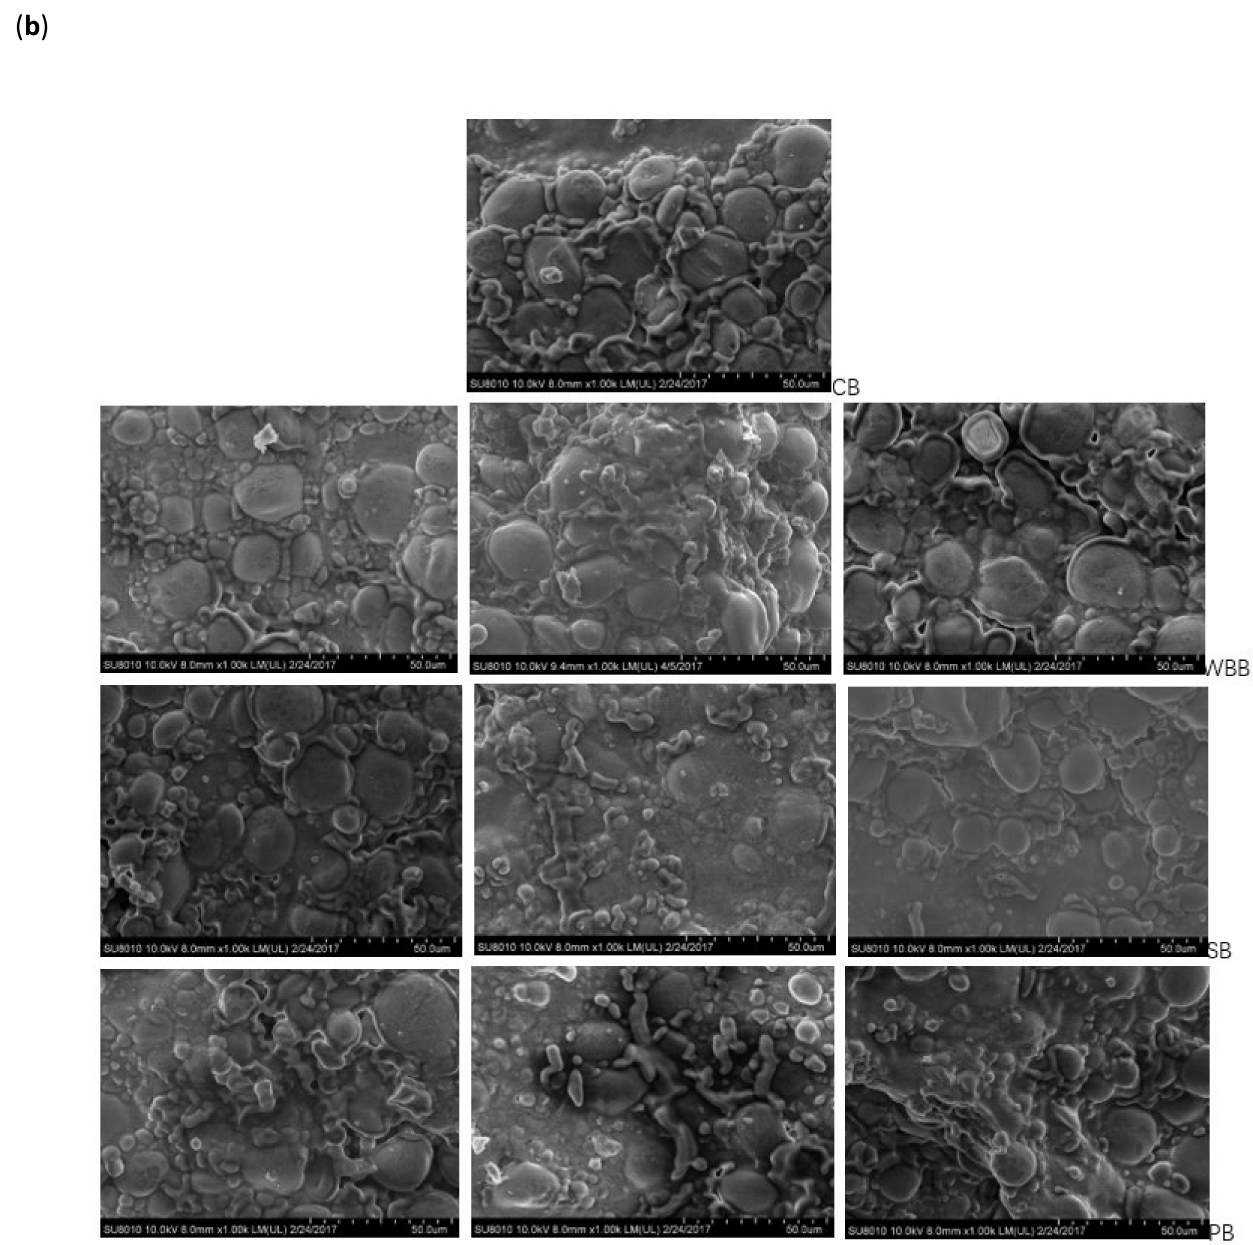
Figure 3. Scanning electron micrographs of bread crumb ( a ) and bread crust ( b ) at 1000 × magnification: the control bread (CB); white button mushroom bread (WBB); shiitake mushroom bread (SB) and porcini mushroom bread (PB). From left to right: 5%; 10% and 15% substituent